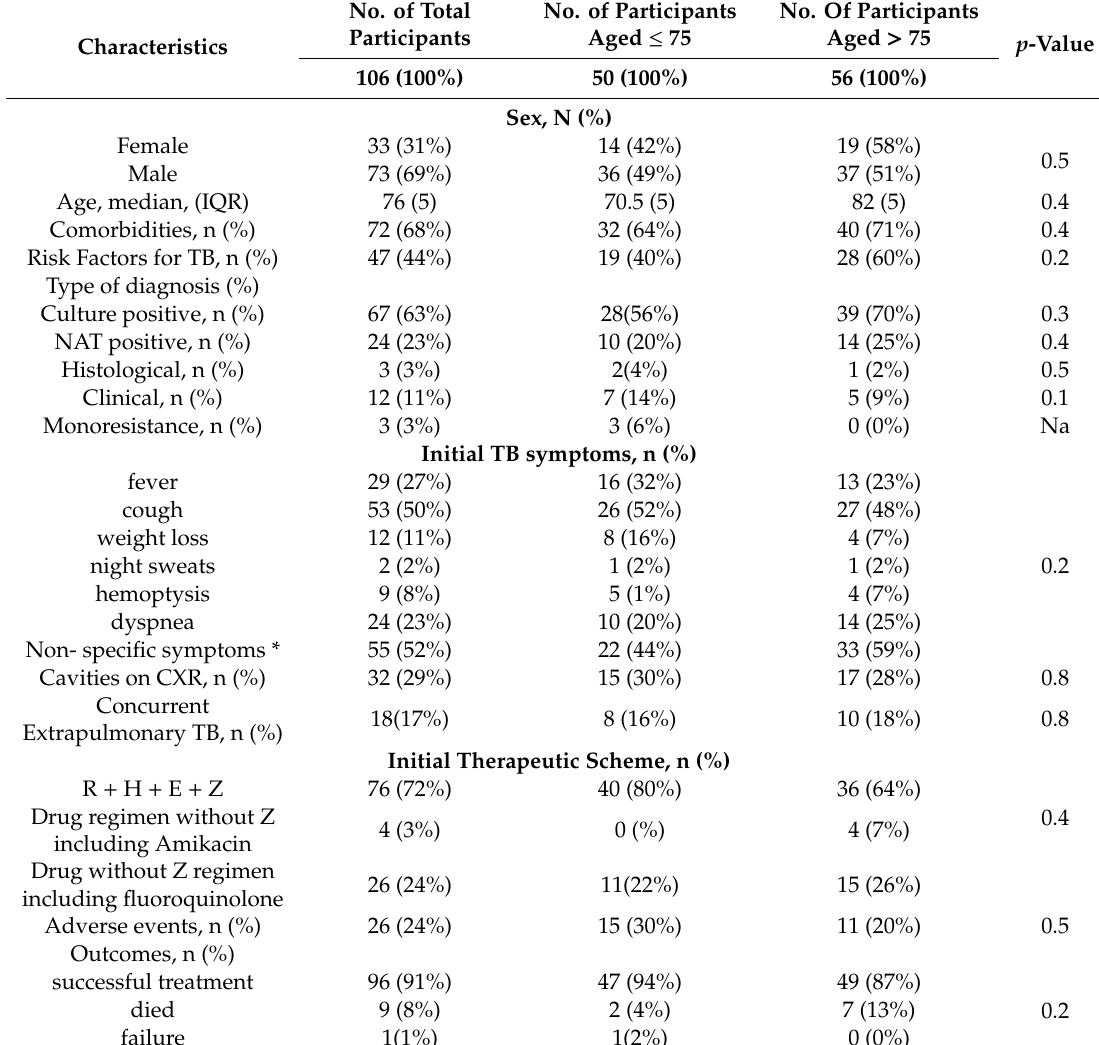
Table 1. Characteristics of participants stratified by age-classes ≤ 75 or > 75 years